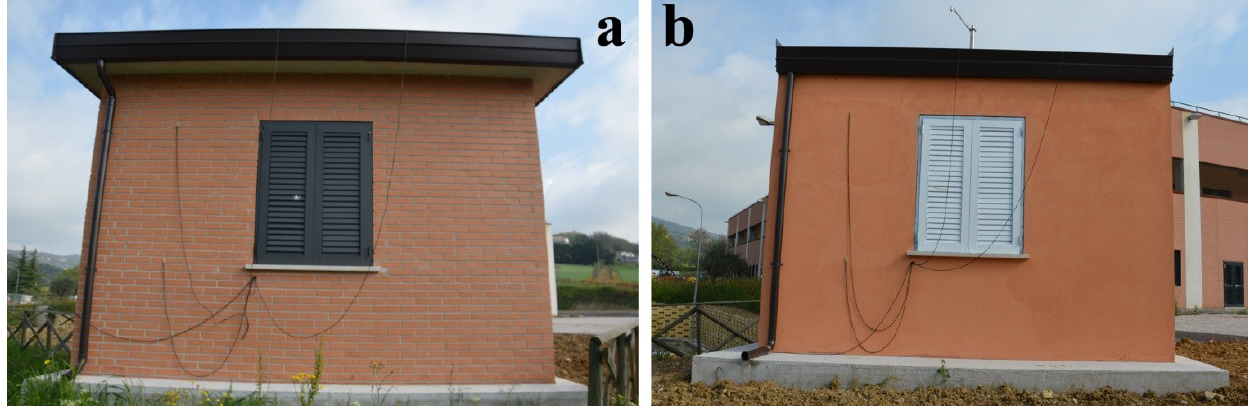
Figure 1. Continuously monitored buildings. ( a ) Test-room 1 with the Dark Shading system; ( b ) Test-room 2 with the Dark Shading